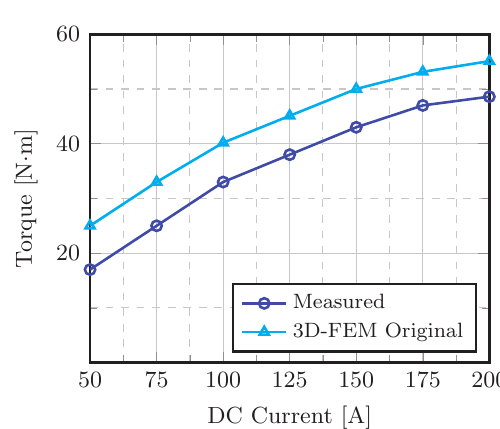
Figure 32. Measured and calculated values of torque with a DC power